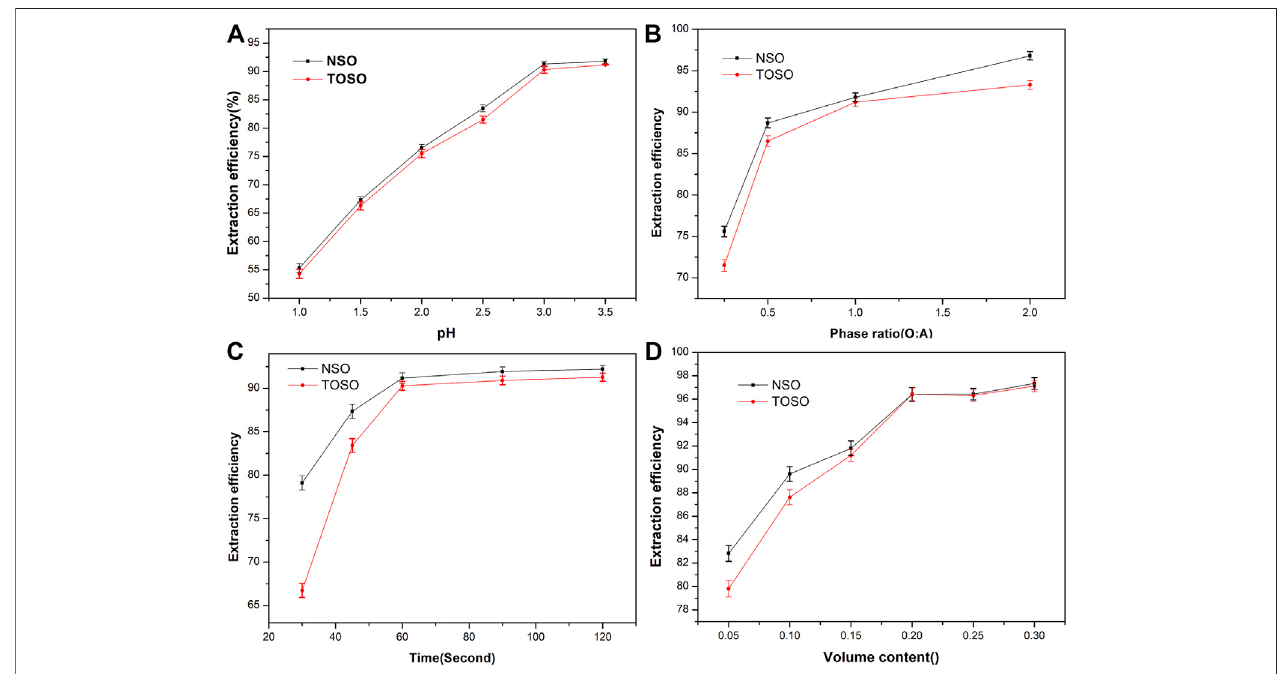
FIGURE 1 | Effects of equilibrium pH (A) , phase ratio A:O (B) , extraction time (C) , and volume content (D) on the recovery of Cu(II) with TOSO and NSO.